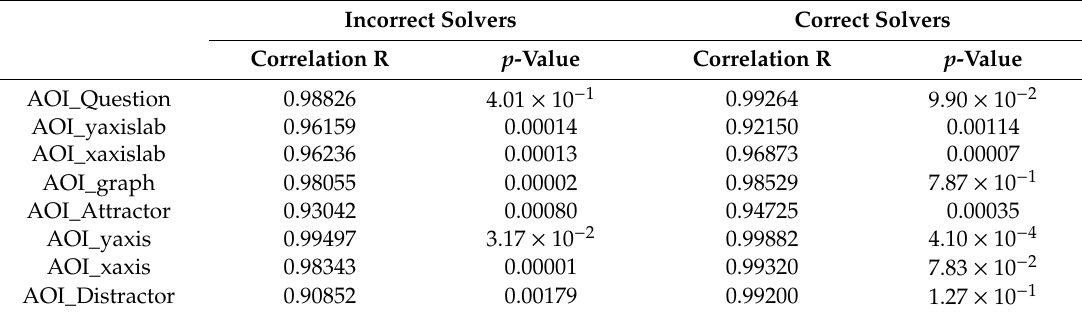
Table 4. Correlations between the direction of transitions for incorrect and correct